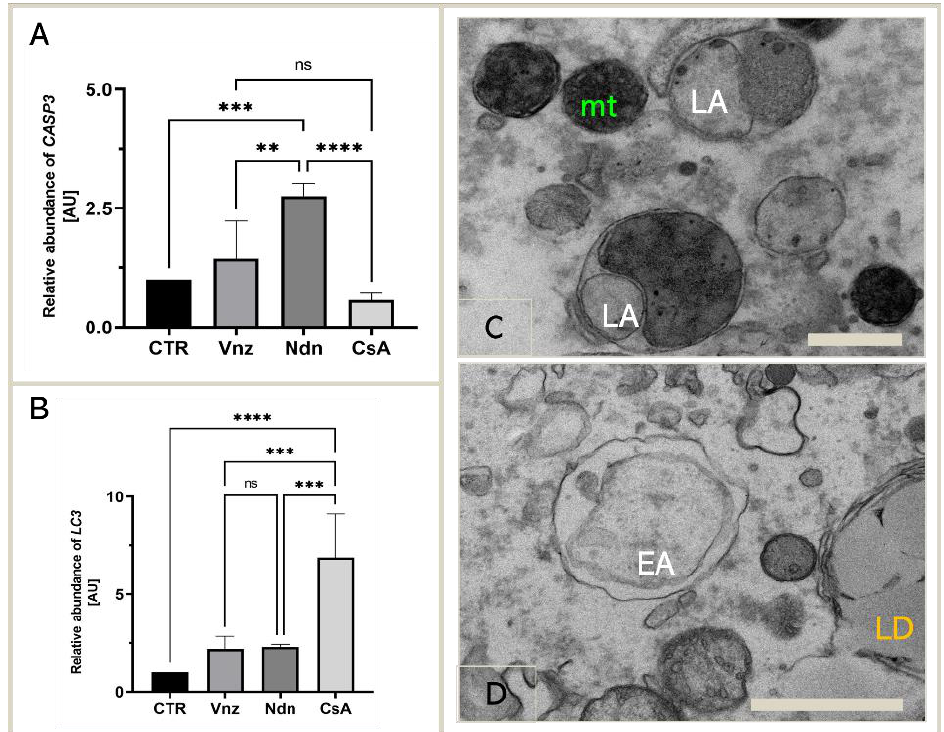
Figure 4. Expression of genes coding for apoptosis and autophagy mediators: CASP3 ( A ) and LC3 ( B ) in porcine COCs subjected to the IVM procedure using a 3D culture model (alginate capsules) in control cultures (CTR) or in experimental cultures: in the presence of vinclozolin (Vnz), nandrolone (Ndn) or cyclosporin A (CsA), shown by RT-qPCR at the transcript level. The results are presented as mean values with n = 5 ± standard deviation (SD); each “ n ” consisted of 50 COCs. Statistical analysis: homogeneity of variance—Brown–Forsythe test; normality of distribution—Bartlett’s test and one-way ANOVA followed by Dunnett’s post hoc test, ** p < 0.01, *** p < 0.001, **** p < 0.0001; ns—nonsignificant. ( C ): The ultrastructure of late autophagosome (LA) in oocytes maturing in vitro in the presence of CsA; scale bars represent 400 nm. ( D ): The ultrastructure of early autophagosome (EA) in oocytes maturing in vitro in the presence of Ndn; scale bars represent 900 nm. mt: mitochondria; LD: lipid droplets.